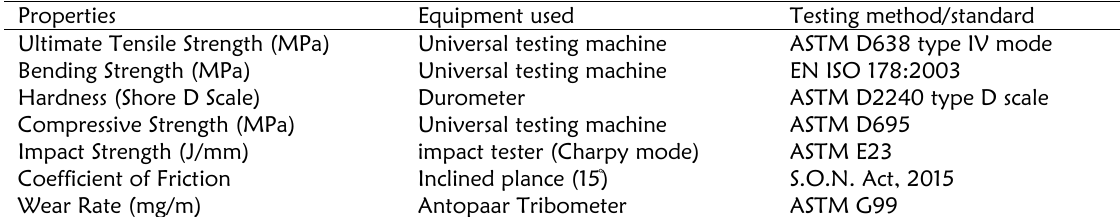
Table 5: Testing Equipment and